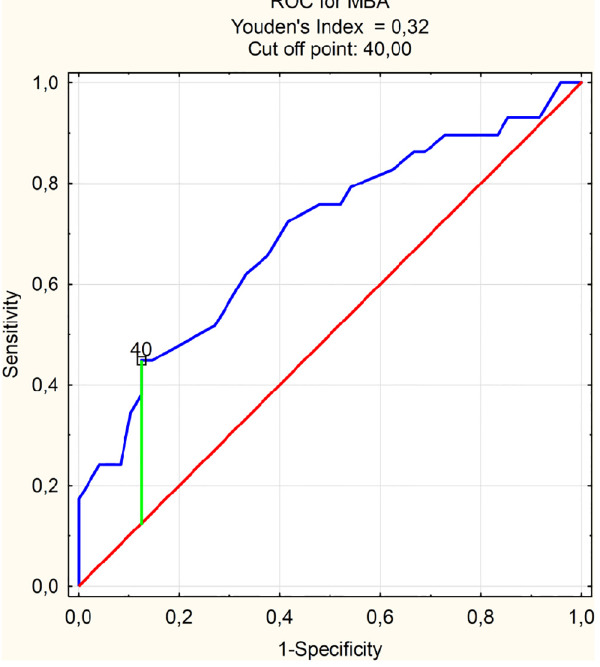
Fig 3. ROC and cut off point for MBA. ROC — receiver operating characteristic.